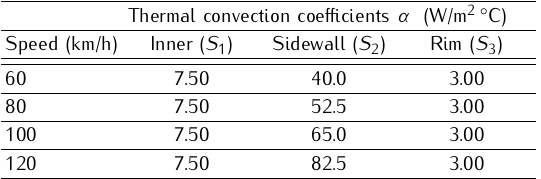
Table 4. Thermal convection coefficients